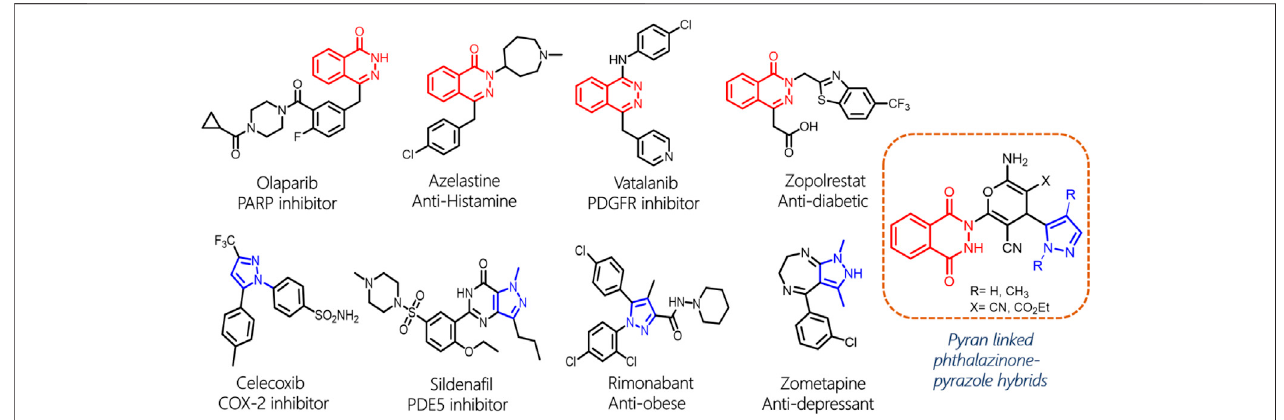
FIGURE 1 | Drugs with phthalazine or pyrazole moieties and design strategy of phthalazine